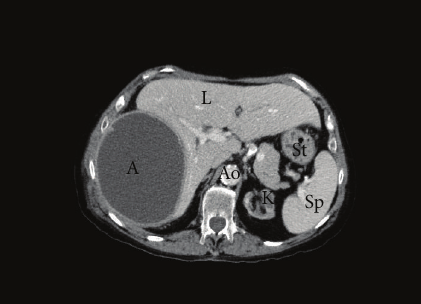
Figure 1: Transesophageal echocardiography showing a tubular 4 × 0.5 cm thrombus (arrow) in superior vena cava (SVC) to the right atrium (RA); left atrium (LA).